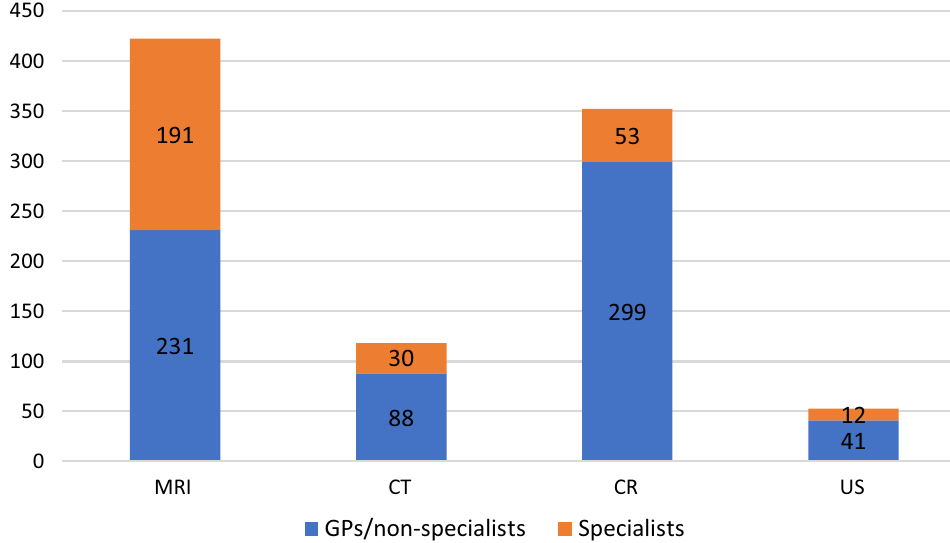
Fig. 4 Referral rates per modality for super-referrers. Rates of use (rates specialists, deemed as super-referrers per modality